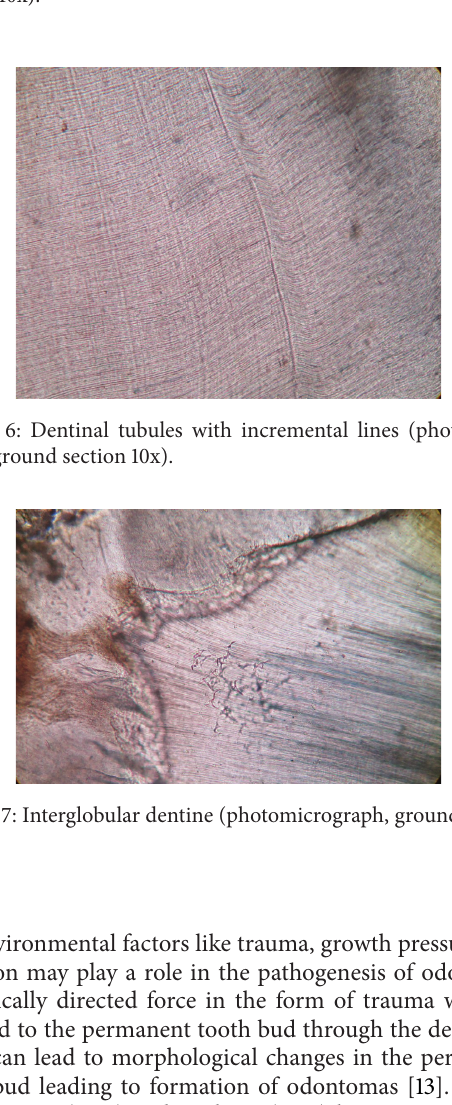
Figure 5: Incremental lines of enamel (photomicrograph, ground section 10x).